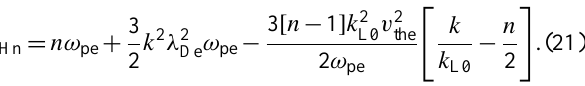
Fig. 2. Schematic of the simultaneous detection of enhanced IAW and LW. The wavenumbers in green would simultaneously detect both enhanced modes.